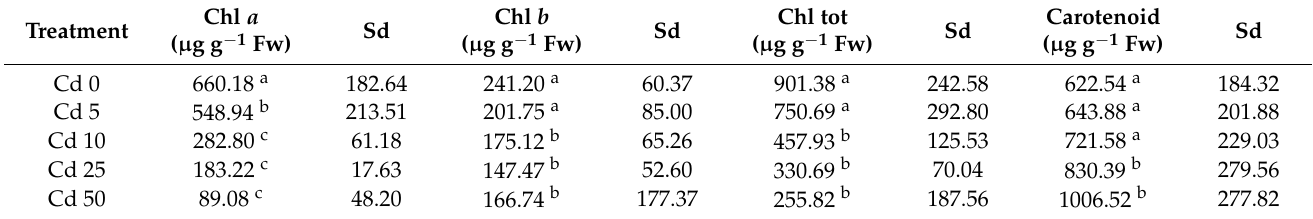
Table 3. Effect of each Cd treatment on chlorophyll a and b (Chl a , Chl b ) and carotenoid content for all the investigated cultivars. Means and standard deviations (sd) followed by different letters within each column indicate statistically significant differences based on the Dunn–Kruskal–Wallis test at p ≤